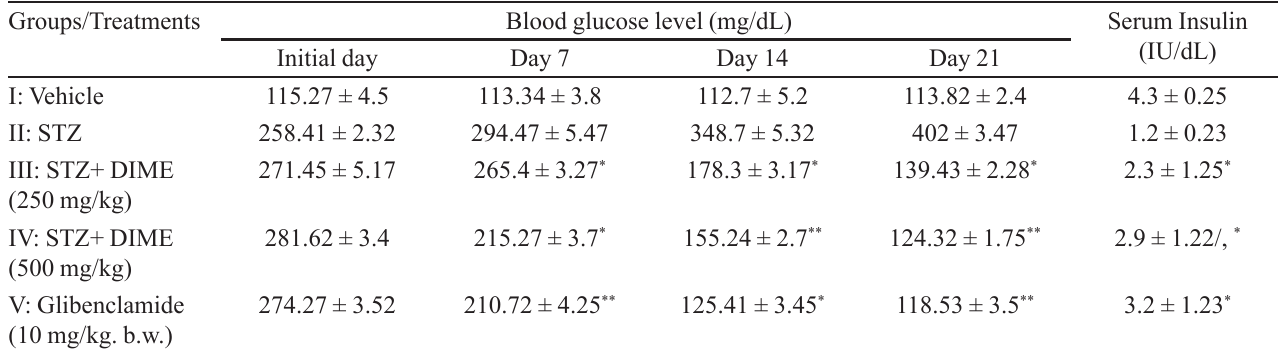
TABLE I - Effect of Dillenia indica leaves extract on blood glucose and insulin levels in diabetic rats